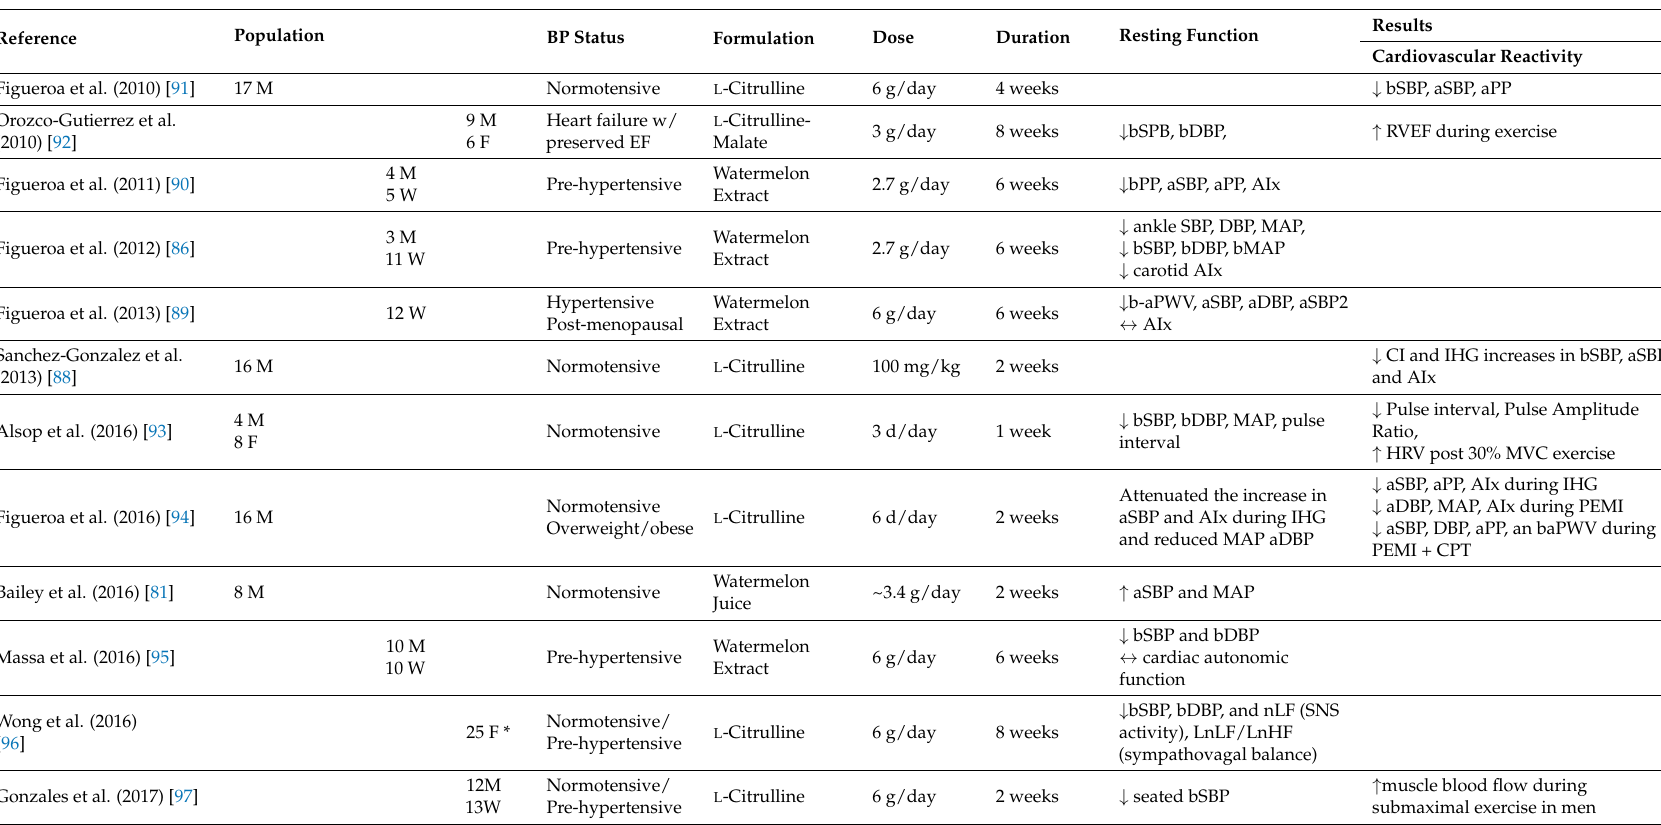
Table 1. A series of human clinical trials that investigated changes, after L -citrulline or watermelon extract supplementation, in blood pressure and associated indices of blood vessel function under resting and physiologically stressful